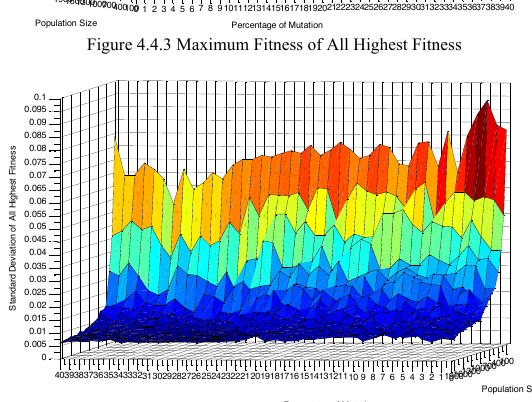
Figure 4.4.4 Standard Deviation of All Highest Fitness Figure 4.4 Total Percentage of Mutation and Crossover is 40% (Mutation over Crossover) Figure 4. Mean, Min, Max and Standard Deviation of all highest fitness generated in each generation for various population size and percentage